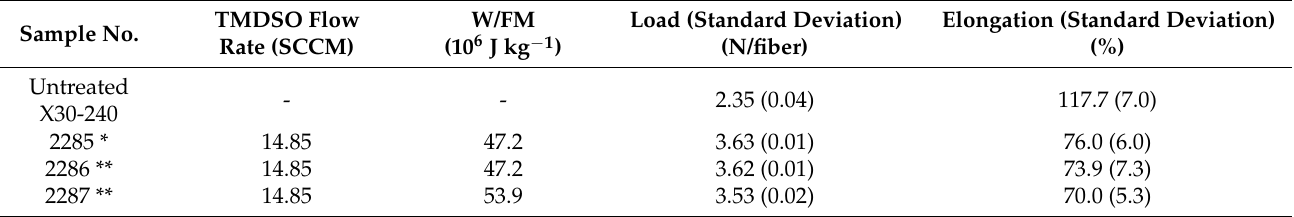
Table 7. Tensile Properties of X30-240 HFM before and after coating with a siloxane plasma polymer. Sample